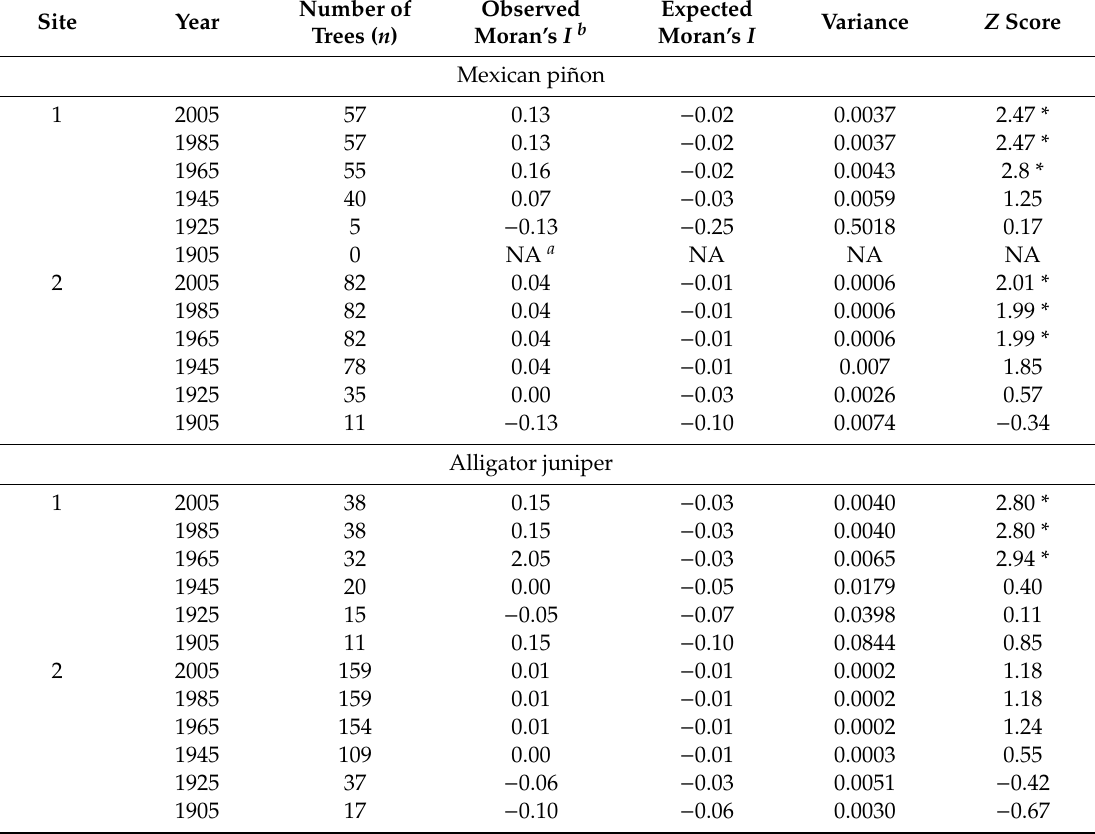
Table 2. Observed, expected, variance, and Z scores of contemporary and historical Moran’s I spatial autocorrelation statistic for Mexican piñon ( Pinus cembroides var. cembroides Zucc.) and alligator juniper ( Juniperus deppeana var. deppeana Steud.). Inverse distance was used as the weighting function in Moran’s I